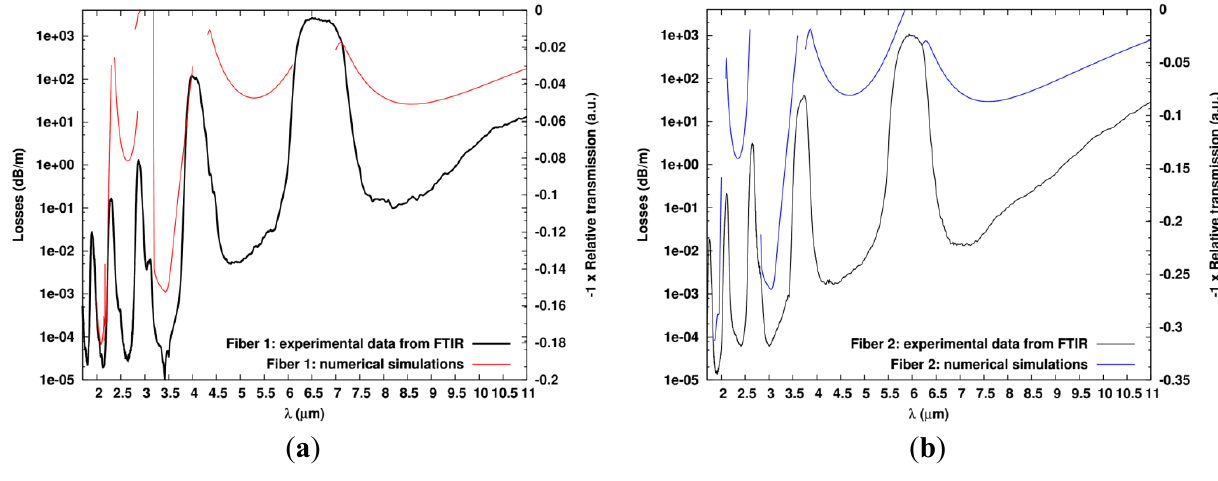
Se used in the numerical simulations and 38 62